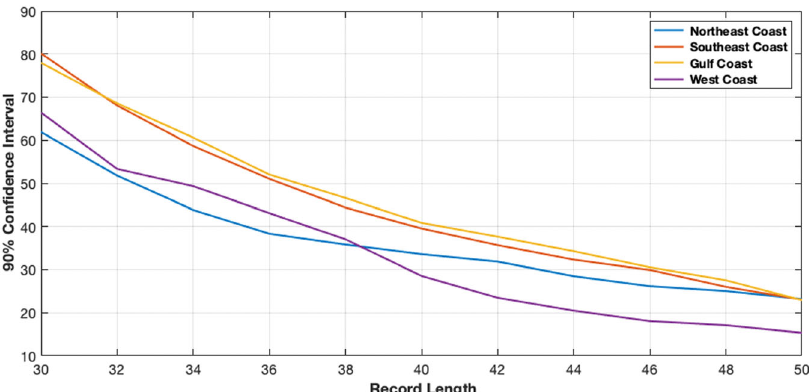
Fig. 7 Narrowing ranges. Width of the 90% con fi dence interval in centimeters for increasing record lengths used in the enveloping approach. Values represent the con fi dence interval width for a 30-year projection, re fl ecting the 30-year projection time period from 2020 to 2050 considered in this